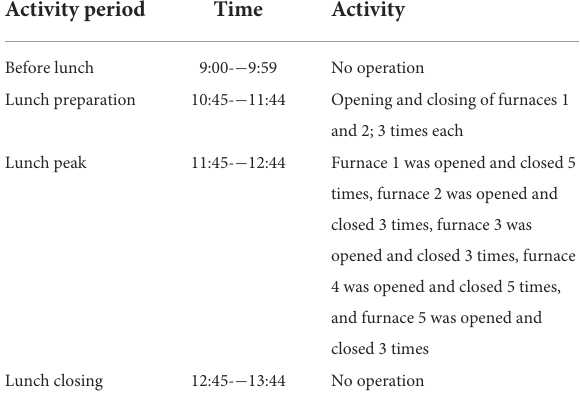
TABLE 2 Record of activities in each lunch period.